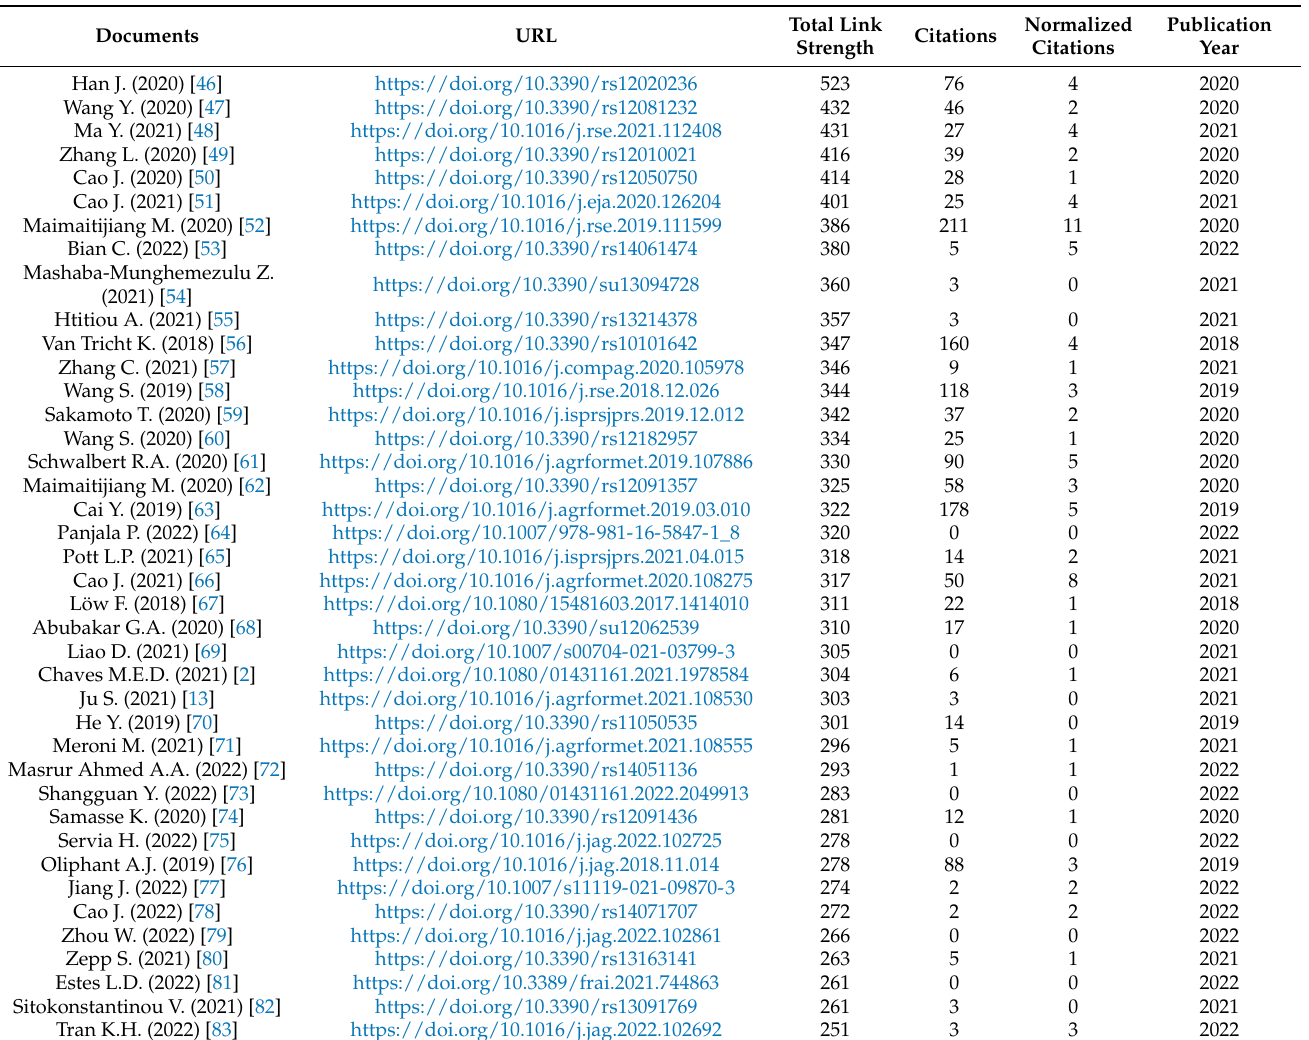
Table 6. Top 40 documents with the highest total link strength for bibliographic data (bibliographic coupling links), considering full counting and 0 as the minimum number of citations of a